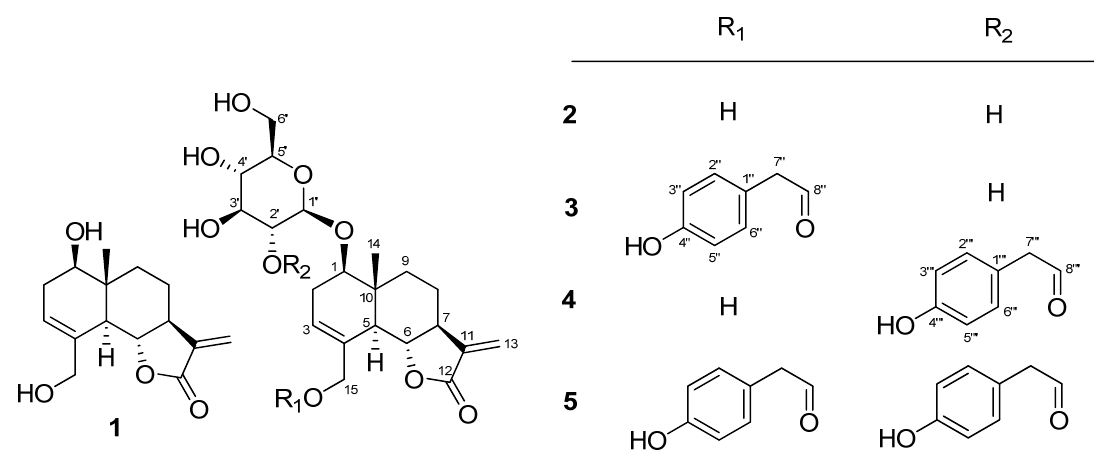
Figure 1. Structures of compounds 1–5 .